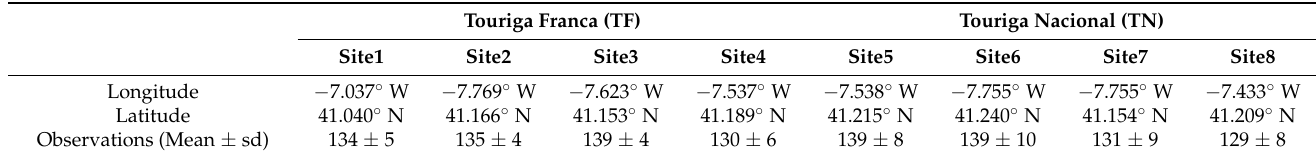
Figure 1. The spatial distribution of ( a ) study sites (numbered per Table 1) where the phenology data of two grapevine varieties (TF: Touriga Franca, TN: Touriga Nacional) are collected within the Douro Demarcated Wine Region and ( b ) the monthly mean of daily minimum (T min , °C), average (T avg ,°C) and maximum (T max , °C) temperatures over 1991 − 2020 (error bars: standard deviation of monthly means), along with the maximum duration (days) of consecutive hot days (T max ≥ 25 °C for at least 5 days) for each month. The meteorological statistics are based on the spatial average of all study sites. Table 1. Mean and standard deviation (sd) of the Day Of Year (DOY) for the observed flowering (BBCH65) of two main grapevine varieties (Touriga Franca: TF; Touriga Nacional: TN) within the Douro Demarcated Region (DDR) during the period of